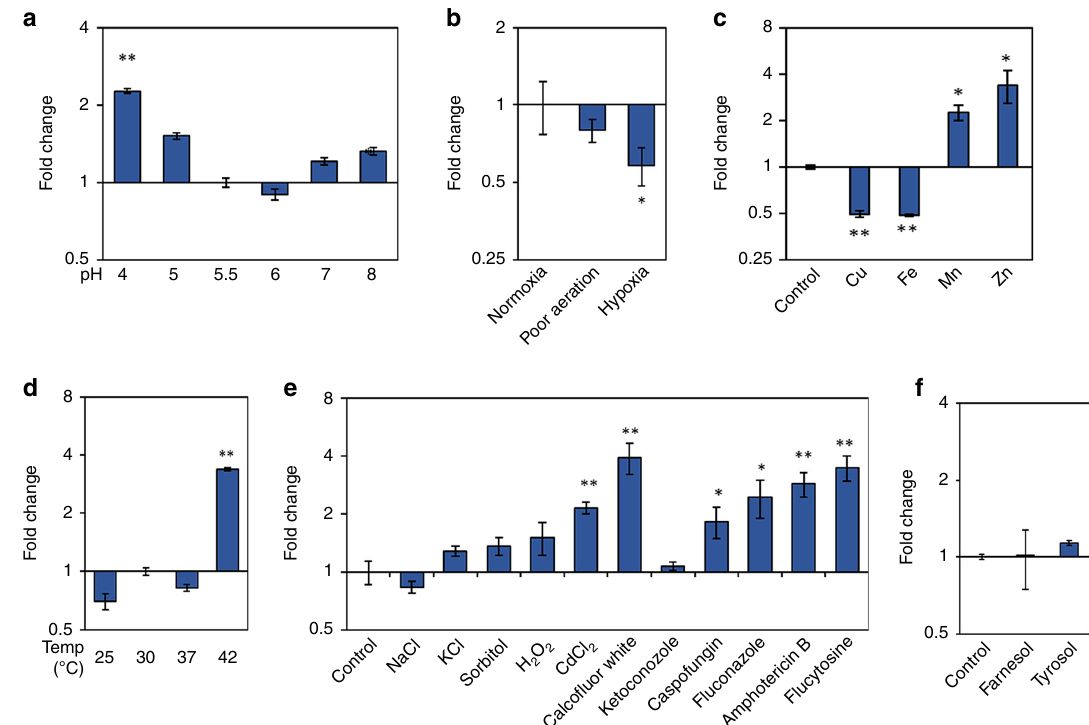
Fig. 2 Speci fi c environmental inputs affect β -glucan exposure in C. albicans . C. albicans SC5314 cells (Supplementary Table 1) were grown overnight in minimal medium, transferred to fresh medium containing a new environmental challenge, and grown for a further 5 h. The cells were then fi xed, stained with Fc-dectin-1, and their levels of β -glucan exposure quanti fi ed by fl ow cytometry (Supplementary Fig. 4). The fold change in β -glucan exposure was calculated relative to the control cells in minimal medium. For most conditions the control medium was SD, but for micronutrient depletion the control medium was LXM. a Impact of adaptation to different ambient pHs on β -glucan exposure. b Effect of changing oxygen levels. c Impact of depletion for speci fi c micronutrients. d Effect of changing the ambient temperature. e Impact of speci fi c environmental stresses: 0.5 M NaCl; 0.3 M KCl; 1.2 M sorbitol; 5 mM H 2 O 2 ; 0.5 mM CdSO 4 ; 200 µ g mL − 1 congo red; 50 µ g mL − 1 calco fl uor white; 0.032 µ g mL − 1 ketoconazole; 0.032 µ g mL − 1 caspofungin; 0.25 µ g mL − 1 fl uconazole; 0.25 µ g mL − 1 amphotericin B; 0.13 µ g mL − 1 fl ucytosine. f Effect of quorum sensing molecules; 50 mM farnesol; 50 mM tyrosol. Means and standard deviations from three independent replicate experiments are shown, and the data were analysed using ANOVA with Tukey ’ s multiple comparison test: * p < 0.05; ** p < 0.01. Source data are provided as a Source Data fi